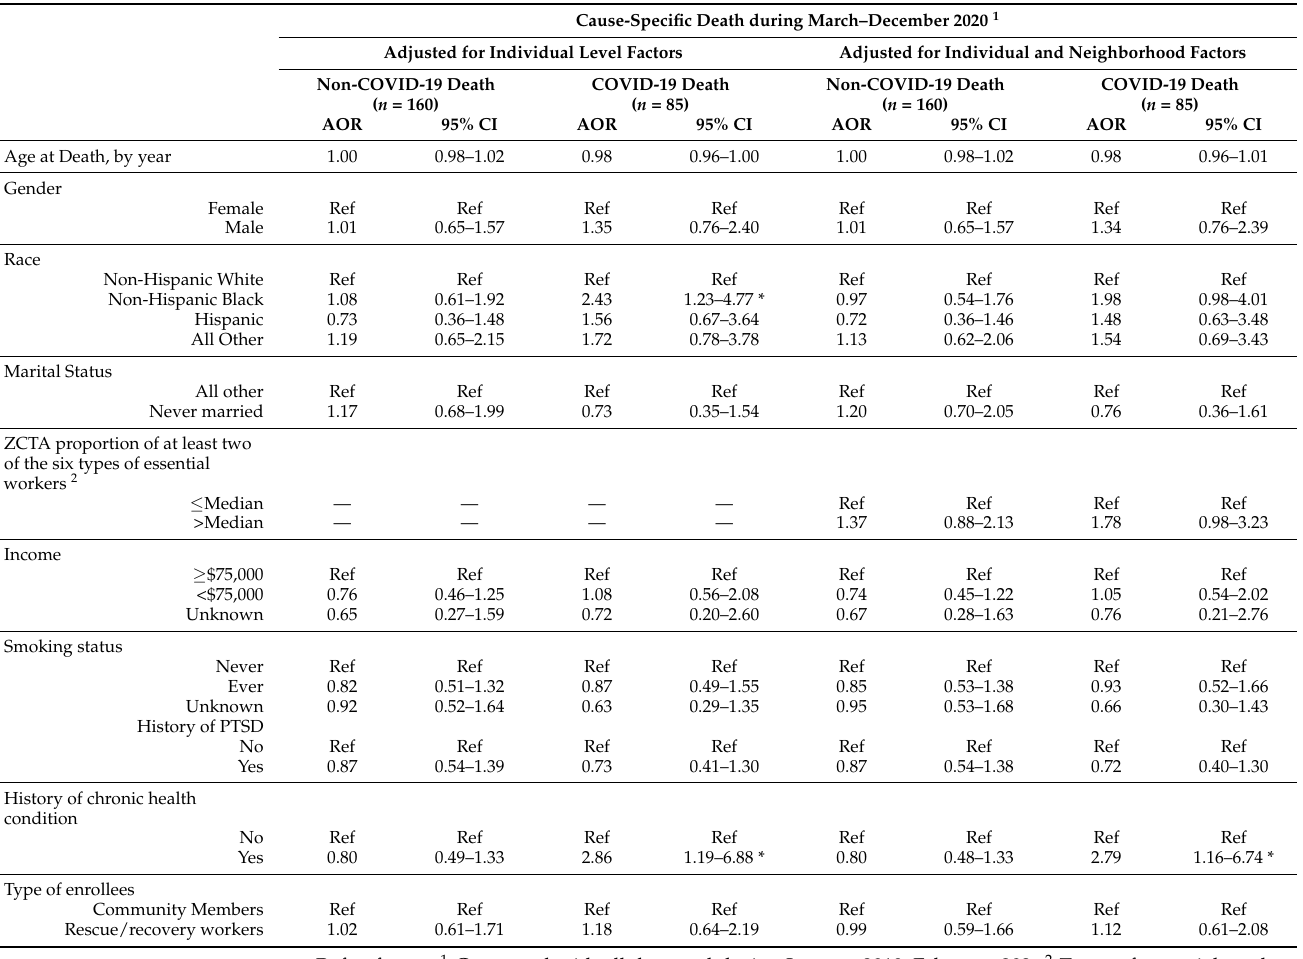
Table 3. Multinomial Analysis of the Association of Socio-economic, Behavioral and